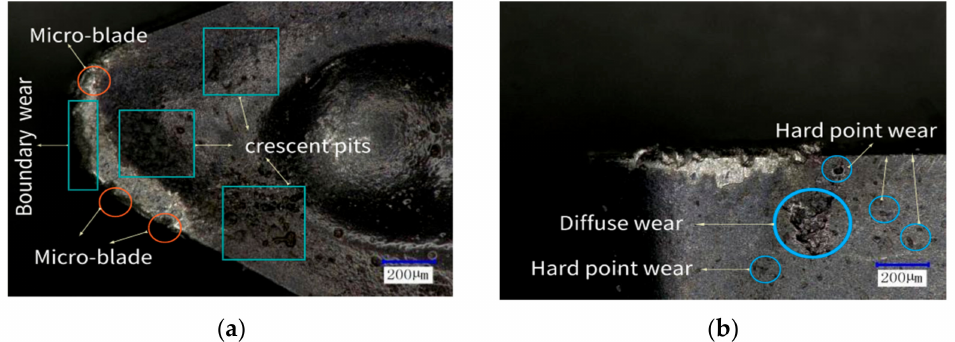
Figure 5. Tool wear morphologies in conventional machining (v c = 50m/min, f = 0.10 mm/rev and ap = 0.5 mm): ( a ) wear morphology on the rake face; ( b ) wear morphology on the flank